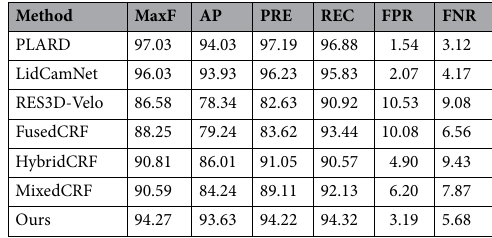
Table 6. Comparison with Several Popular Fusion-based Methods on URBAN_ROAD (BEV) (/%).